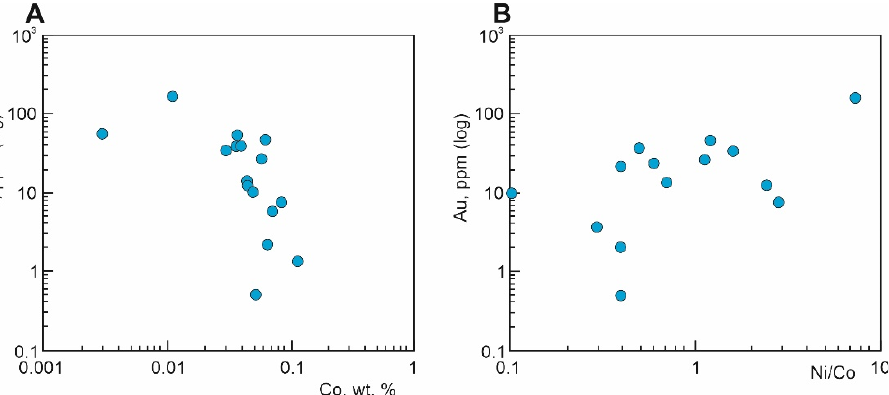
Figure 21. ( A ) Graph showing the relationship between the concentration of Co and Au in Py3 of the studied deposits; ( B ) graph showing the relationship between the concentration of Au and the Ni/Co indicator of the studied deposits.